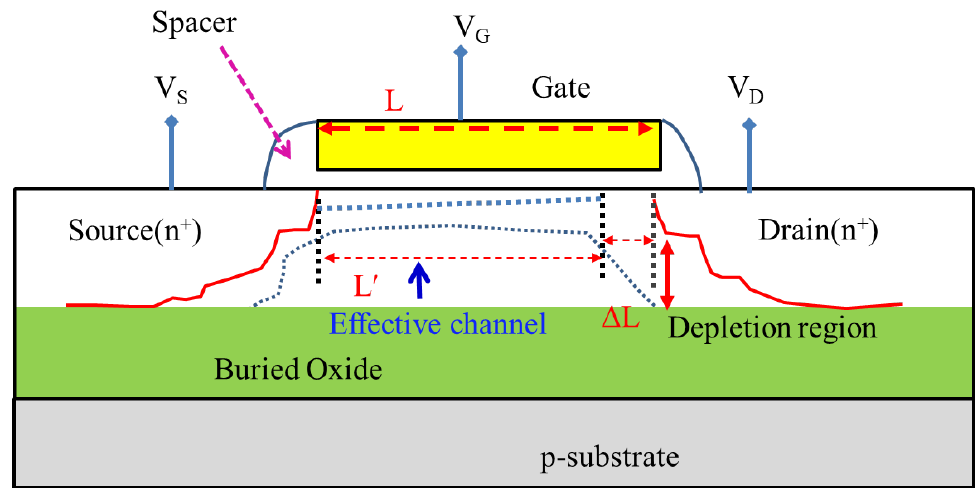
Figure 8. The concise cross-sectional contour of an n-channel FinFET.